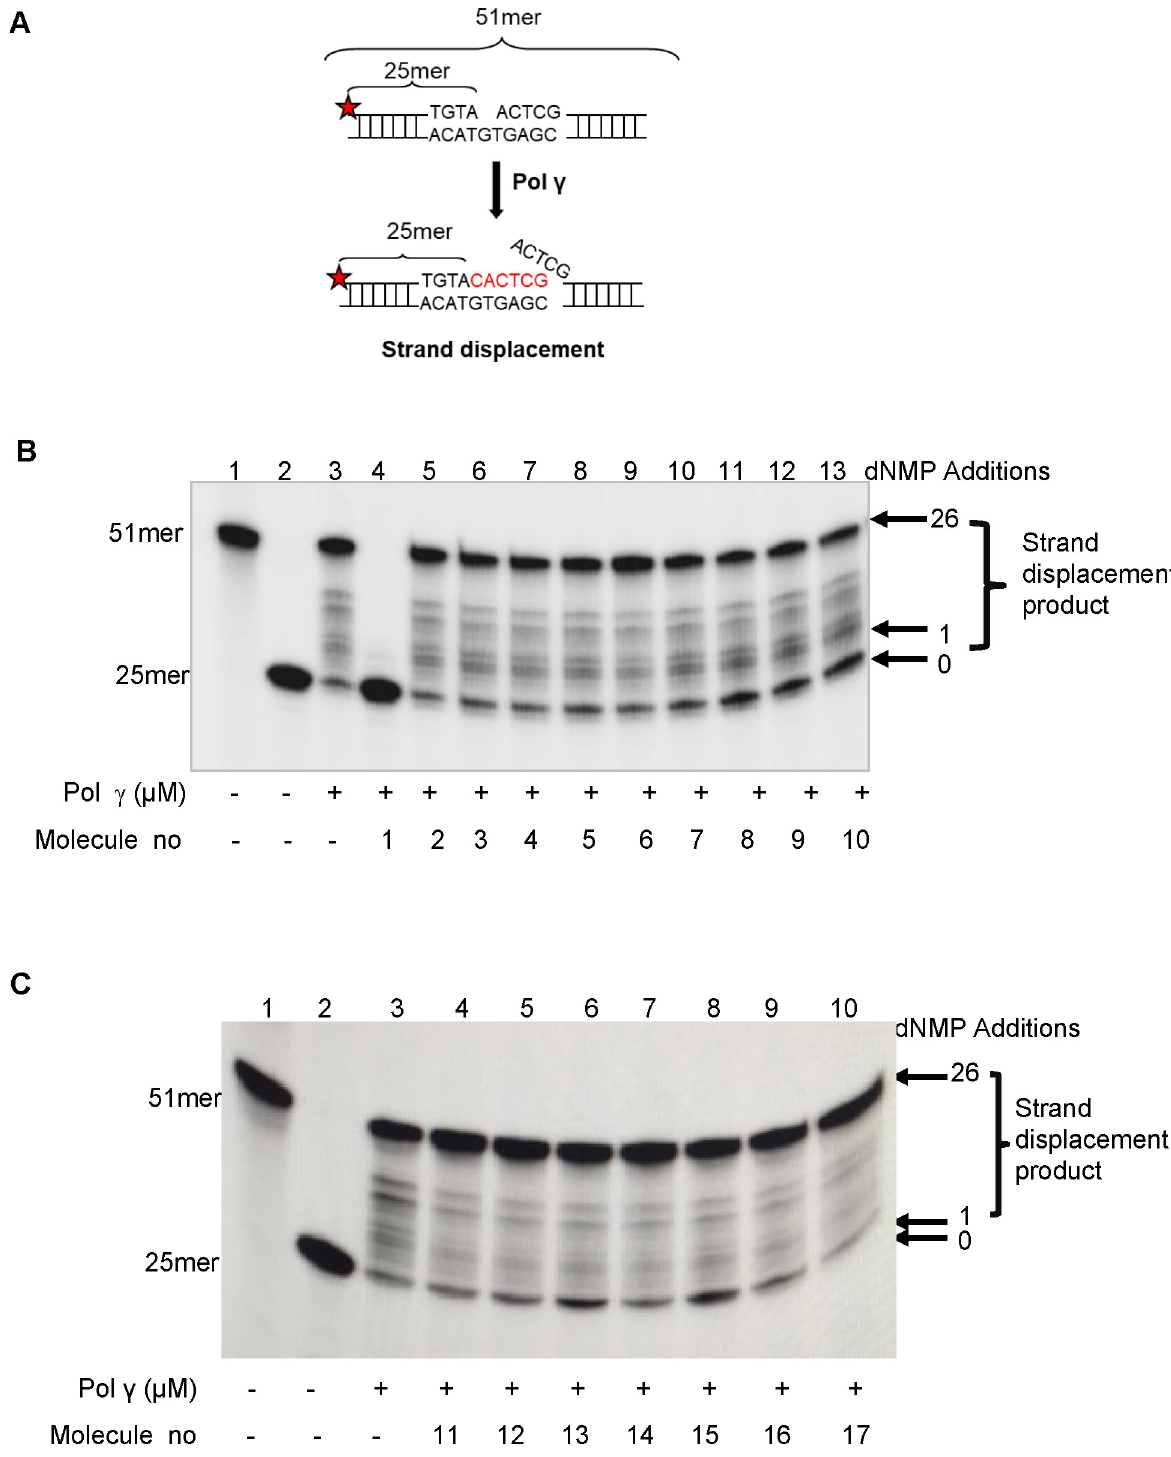
Fig 2. Screening the small molecules on the strand displacement DNA synthesis activity of Pol γ . (A) Schematic of the 32 P-labeled (red star) 51 bp DNA substrate containing 1-nt gap at position 26 is shown before and after Pol γ strand displacement activity. Reactions contained the substrate and Pol γ alone (40 nM; lane 3) or together with 20 μ M of the small molecules. (B) Molecule no 1–10: CR, corilagin, carbamazepine, phenolphthalein, acemetacin, indomethacin, amikacin hydrate, chenodiol, econazole nitrate, and ketoconazole, respectively. (C) Molecule no 11– 17: Nicardipine hydrochloride, miconazole, nialamide, nystatin, misoprostol, pimethixene maleate, and rifampicin, respectively. Lane 1, 51mer oligodeoxynucleotide; lane 2, substrate alone. https://doi.org/10.1371/journal.pone.0268391.g002 PLOS ONE | https://doi.org/10.1371/journal.pone.0268391 June 3,